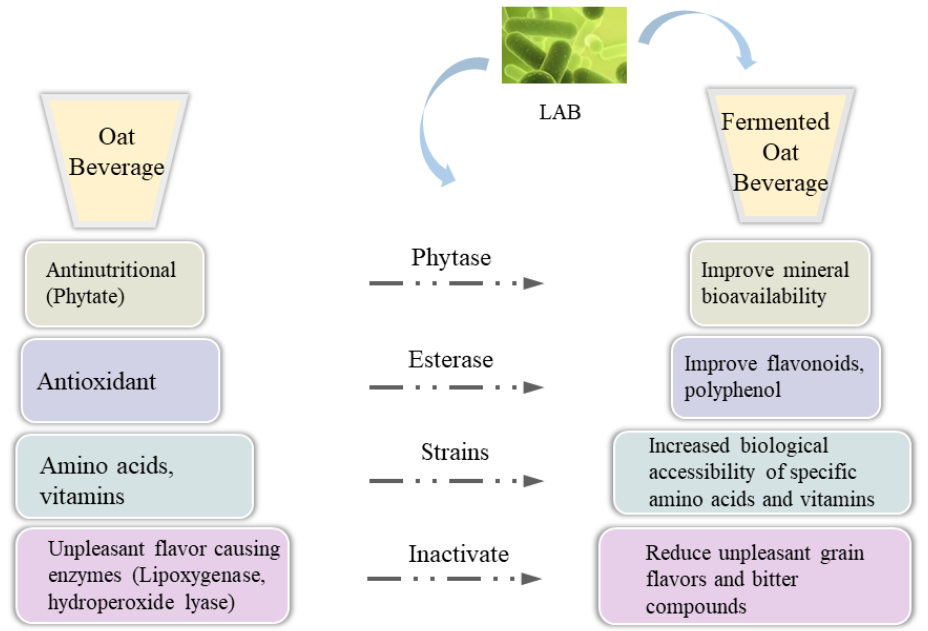
Figure 3. Fermentation improves the nutritional and sensory profile of oat beverages.